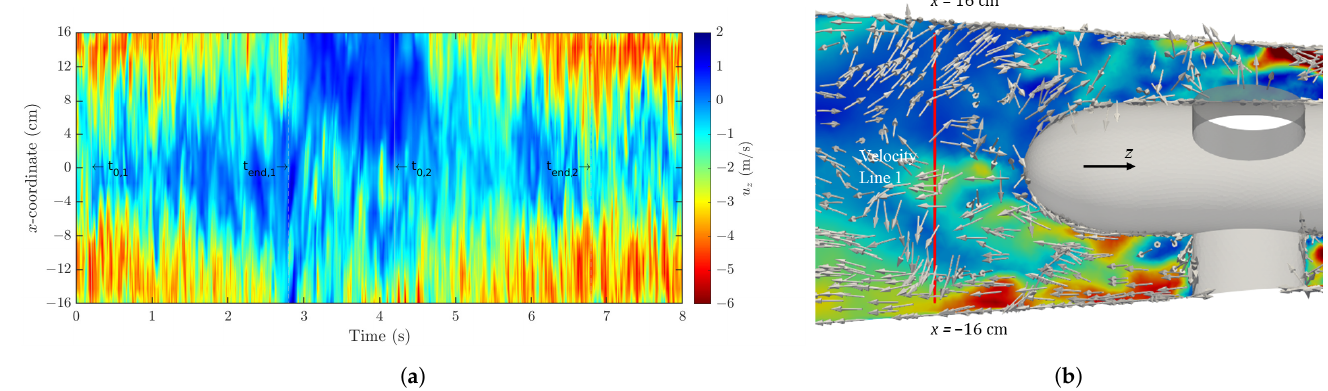
Figure 6. Axial velocity contour and a zoom-in view of a meridional plane with velocity vectors during the transient sequence in turbine mode. ( a , b ) use the same colour bar and vertical axis. The axial velocity is here defined as positive in the negative z -direction (see Figure 1b). ( a ) Contour of axial velocity at Line 1 (downstream) during the turbine mode transients. ( b ) Axial velocity and velocity vectors at t = 4 s. Velocity Line 1 is shown in